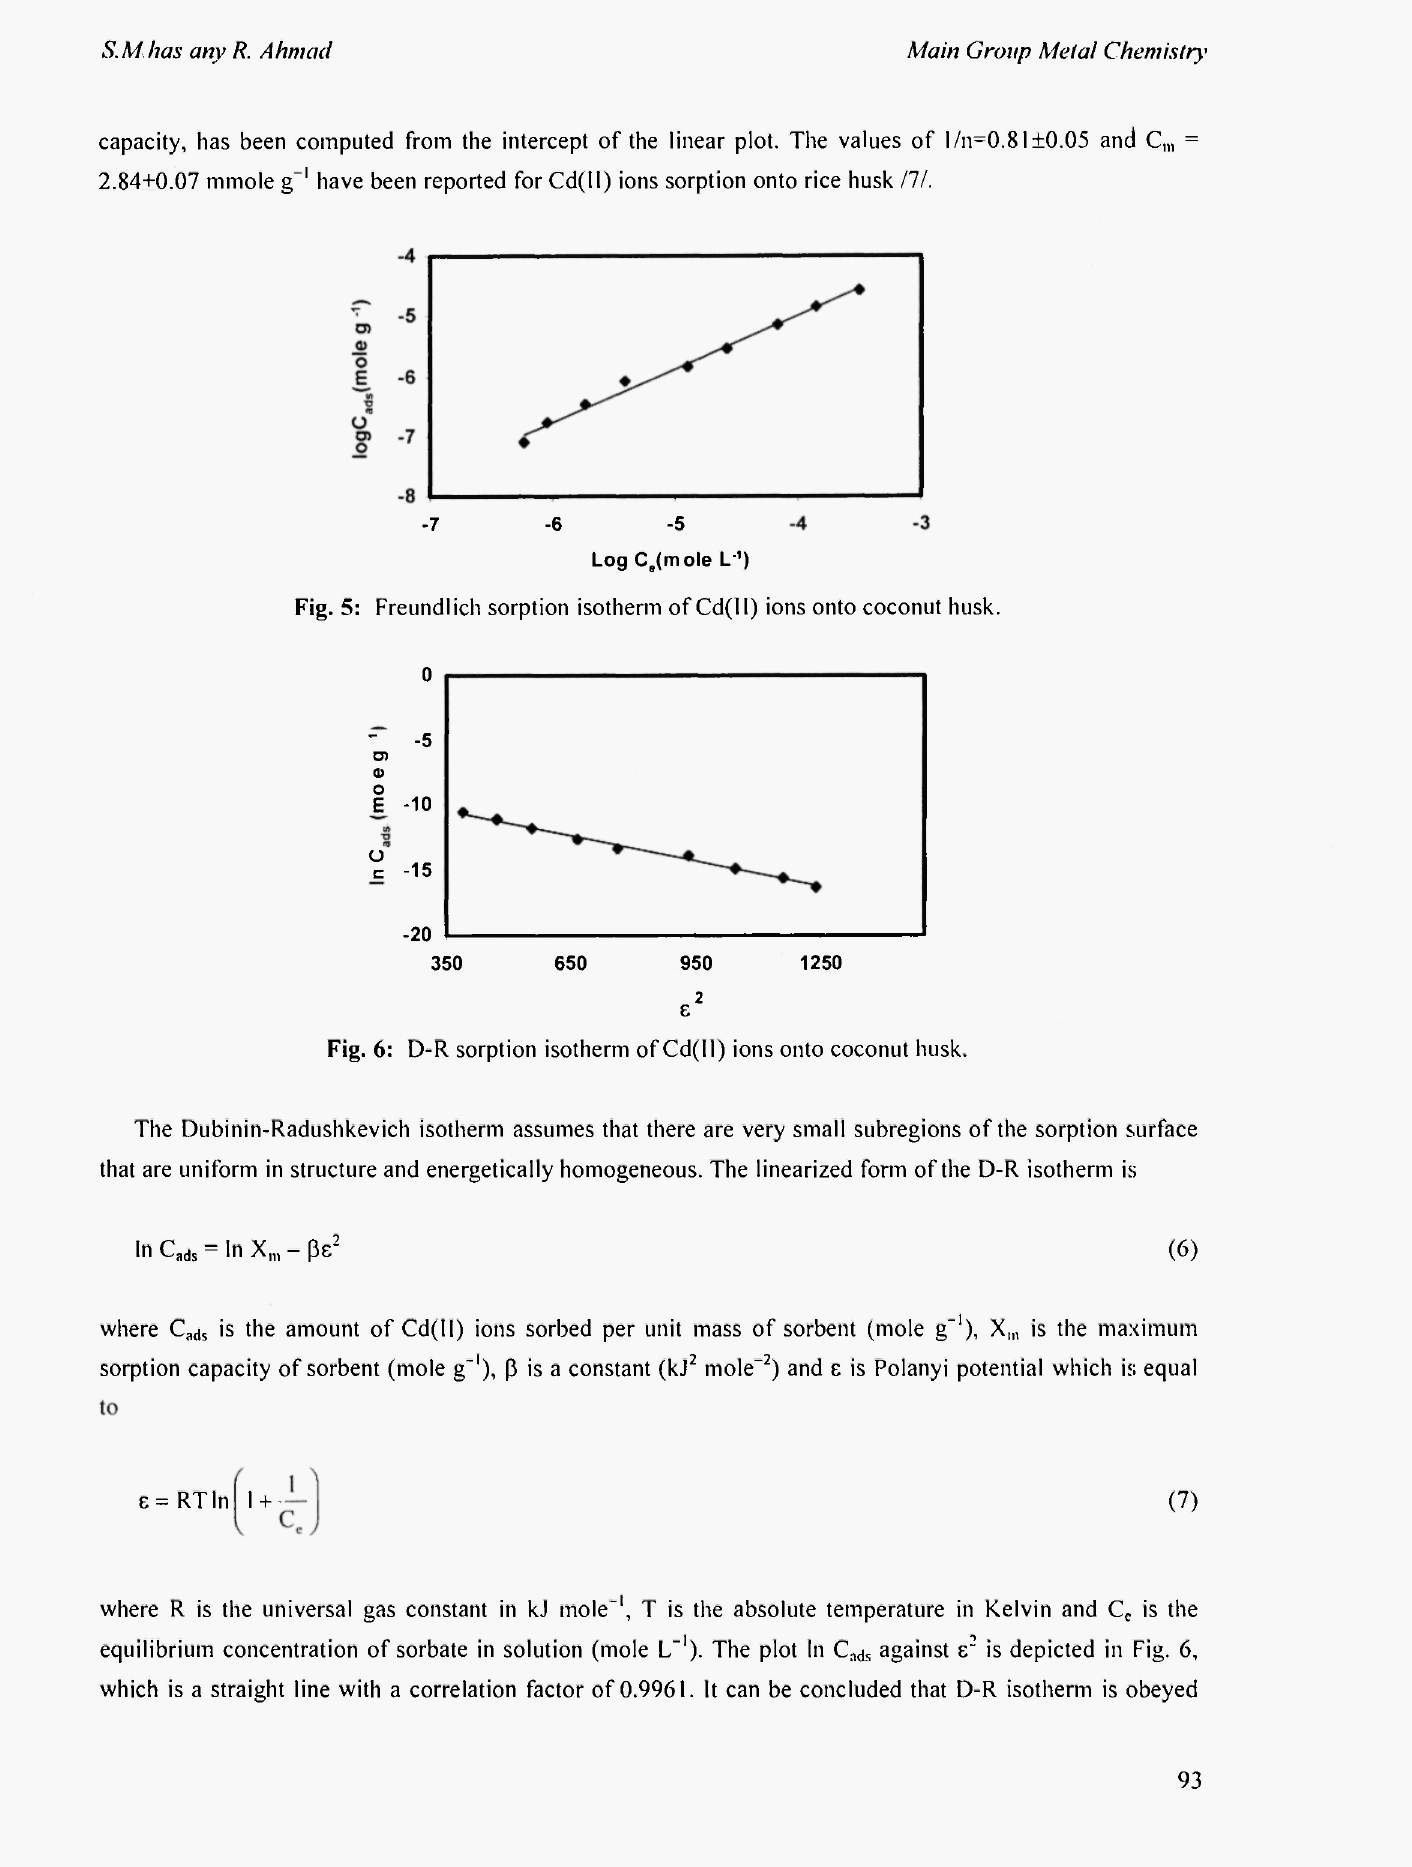
Fig. 6: D-R sorption isotherm of Cd(Il) ions onto coconut